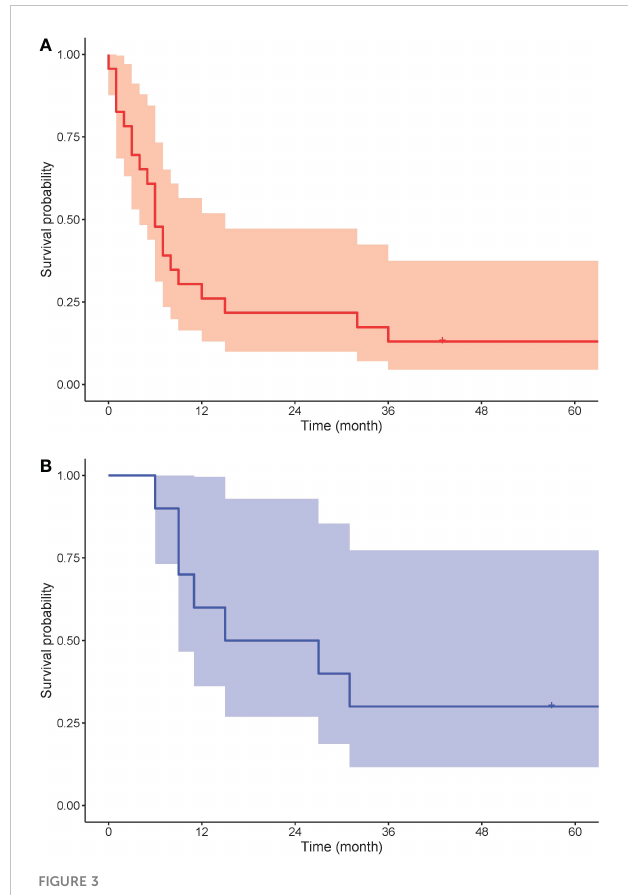
FIGURE 3 Kaplan-Meier survival analysis for overall survival of (A) PDAC (red) and (B) BTC